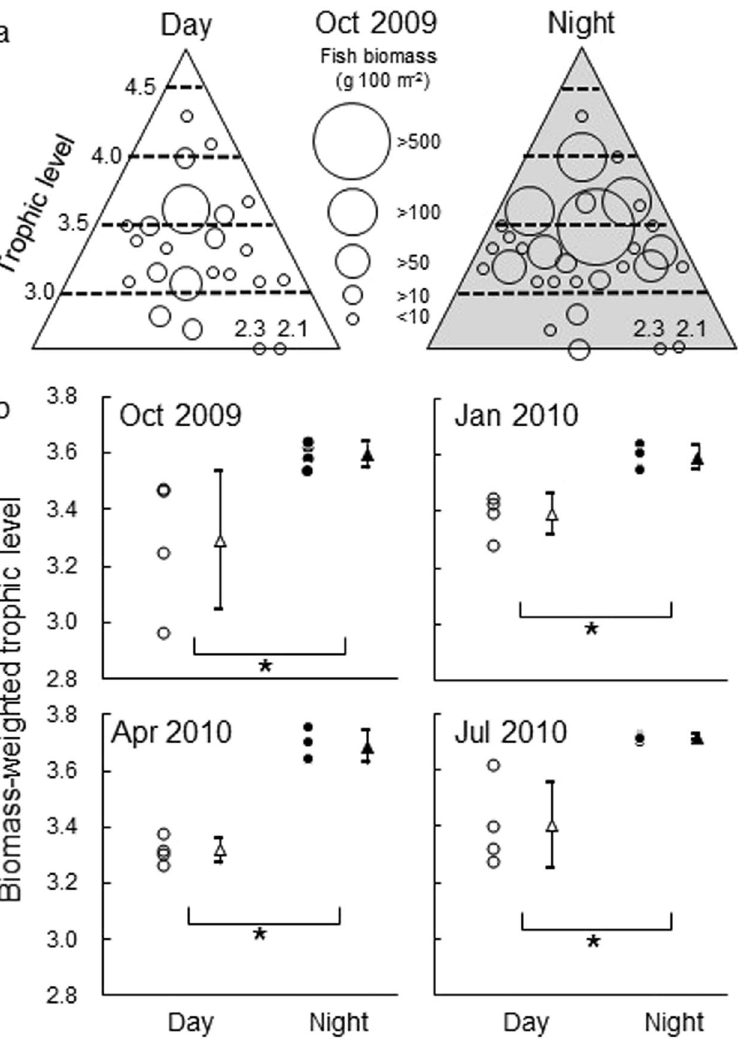
Figure 4. A schematic drawing of day/night changes in the trophic level and biomass (g 100 m − 2 ) of each fish species in October 2009 ( a ), and a comparison of mean biomass-weighted trophic level between daytime (open symbols) and nighttime (closed symbols) in each season ( b ). Circles indicate the biomass-weighted trophic level calculated for each sampling trial, and triangles indicate the mean value (n = 4). The vertical bar represents the standard deviation and the asterisk indicates a significant difference between the daytime and nighttime within the same month (Wilcoxon test, p < 0.05). The trophic level of each fish species is summarized in Supplementary Table